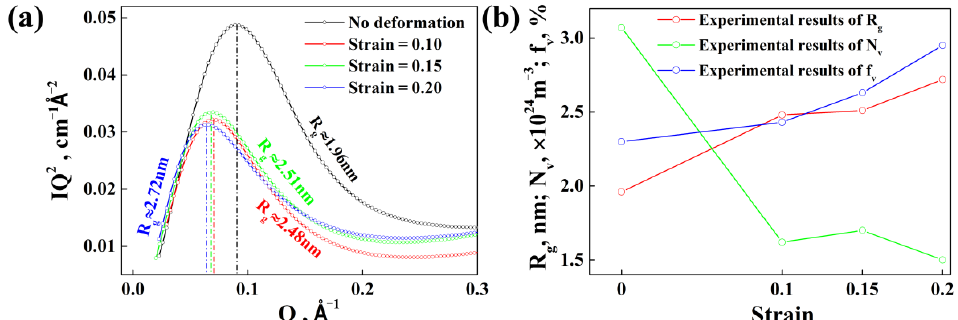
Figure 5. ( a ) Guinier radius R g of specimens with different strains; ( b ) experimental results for average radius R g , volume fraction f v , and number density N v of precipitates for specimens after isothermal heat treatment at 120 °C for 28 h with different strains.